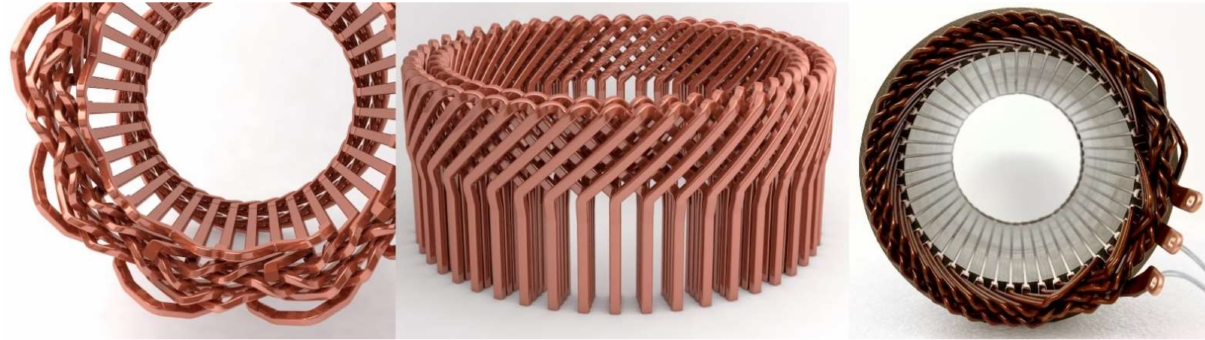
Figure 16. 3D-printed hairpin distributed windings for E-traction motors